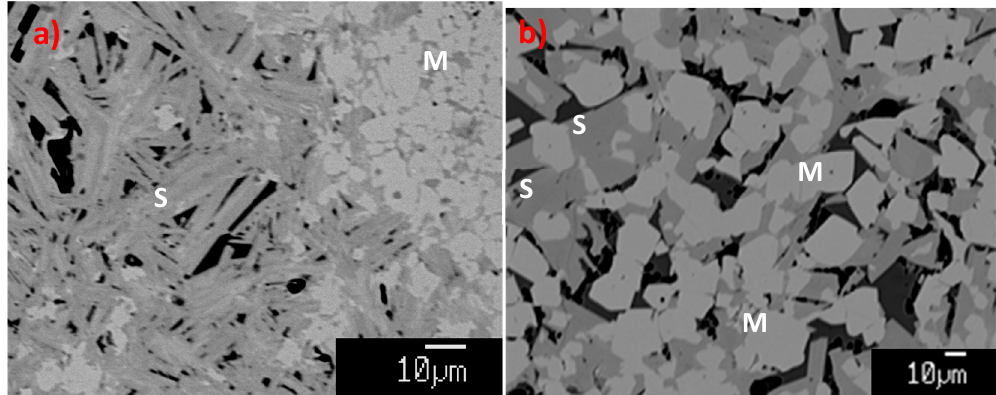
Figure 12. Microstructures of the silico ferrite of calcium and aluminium (SFCA) and magnetite phase